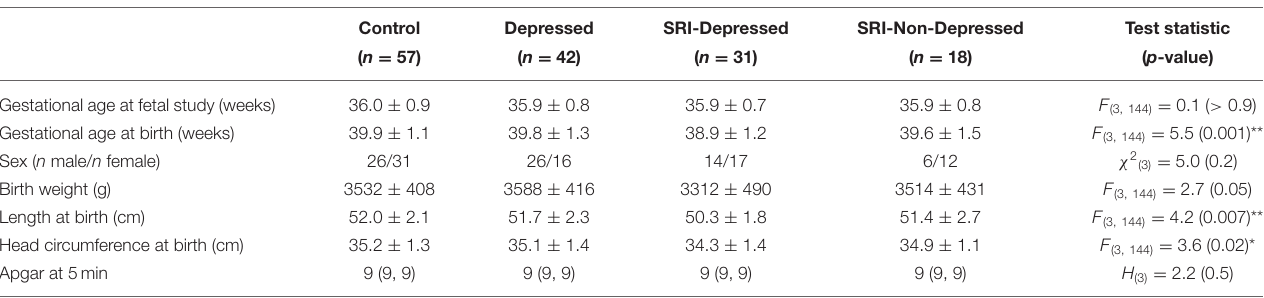
TABLE 2 | Fetal characteristics ( n = 148).